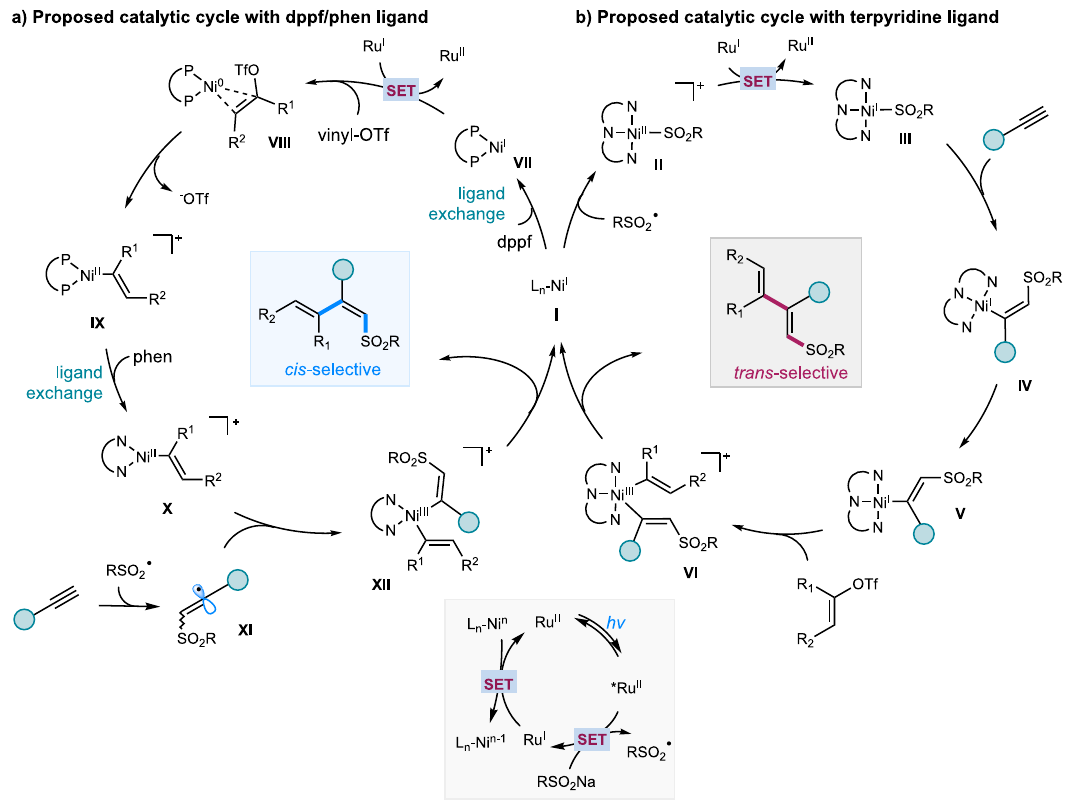
Fig. 6 | Proposed reaction pathways. a Proposed catalytic cycle with dppf/phen ligand. b Proposed catalytic cycle with terpydine ligand. dppf = 1,1-bis(diphenylpho- sphino)ferrocene; phen = 1,10-phenanthroline. hv = visible light. SET = single electron